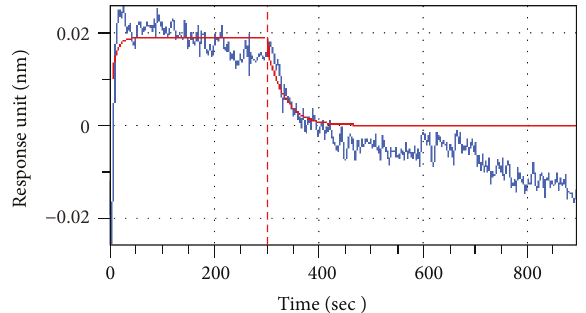
Figure 5: Association between FLPNF and hIAPP. Representative curve obtained using biolayer interferometry showing the level of interaction between immobilized FLPNF and hIAPP (100 μ M) in PBS. During the fi rst 300 seconds, the association curve represented a rapid increase in response units. Over the next 600 seconds, the response units were slowly dropped to